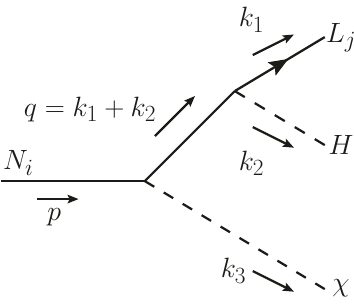
Figure 2 . The three-body decay of a RH neutrino N i at tree level including the scalar χ .